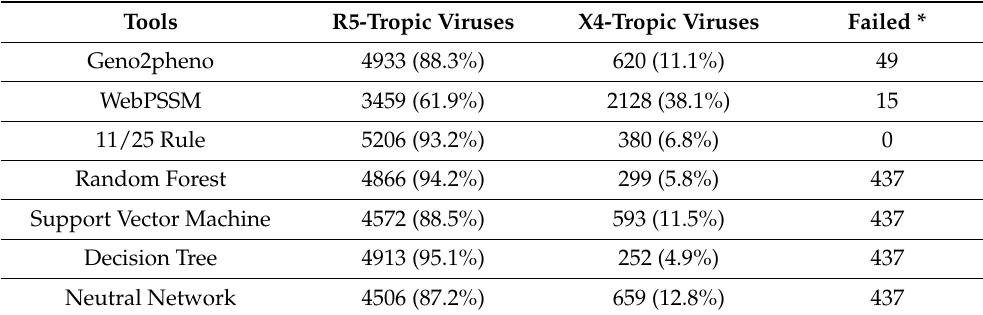
Table 1. Prediction of coreceptor usage using 7 genotypic tools, n = 5602 HIV-1C sequences. Tools R5-Tropic Viruses X4-Tropic